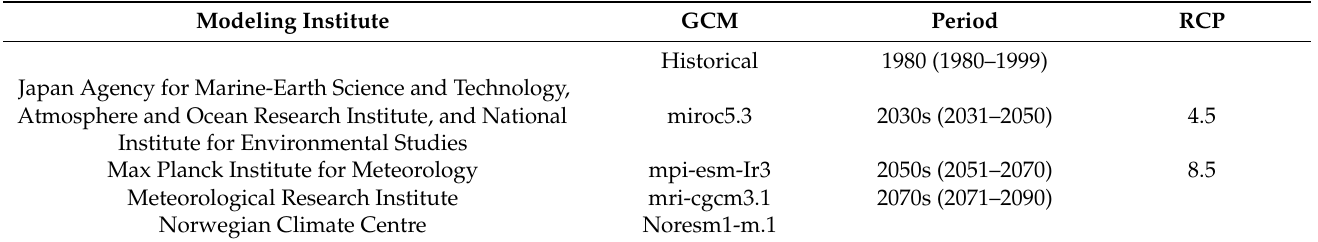
Table 2. Global Circulation Models (GCMs) chosen for future climate scenario analysis using